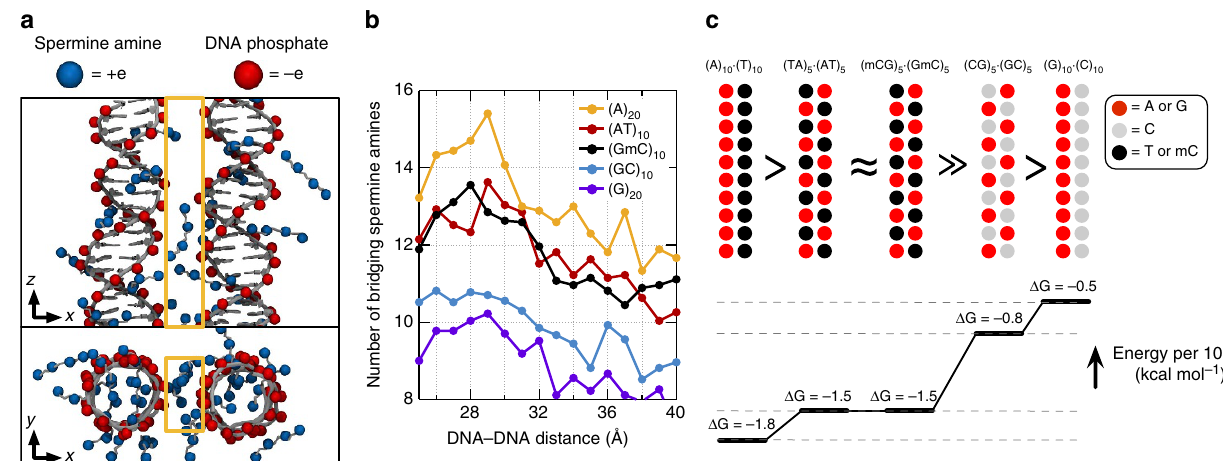
Figure 3 | Methylation modulates the interaction free energy of two dsDNA molecules by altering the number of bridging Sm 4 þ . ( a ) Typical spatial arrangement of Sm 4 þ molecules around a pair of DNA helices. The phosphates groups of DNA and the amine groups of Sm 4 þ are shown as red and blue spheres, respectively. ‘Bridging’ Sm 4 þ molecules reside between the DNA helices. Orange rectangles illustrate the volume used for counting the number of bridging Sm 4 þ molecules. ( b ) The number of bridging amine groups as a function of the inter-DNA distance. The total number of Sm 4 þ nitrogen atoms was computed by averaging over the corresponding MD trajectory and the 10Å ( x axis) by 20Å ( y axis) rectangle prism volume ( a ) centred between the DNA molecules. ( c ) Schematic representation of the dependence of the interaction free energy of two DNA molecules on their nucleotide sequence. The number and spatial arrangement of nucleotides carrying a methyl group (T or mC) determine the interaction free energy of two dsDNA